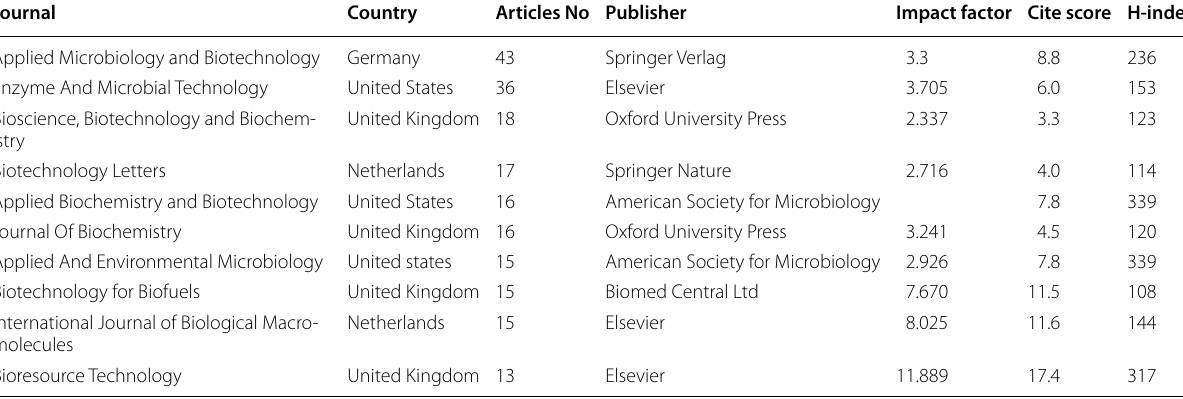
Table 2 Top 10 of the most relevant sources for thermostable enzymes